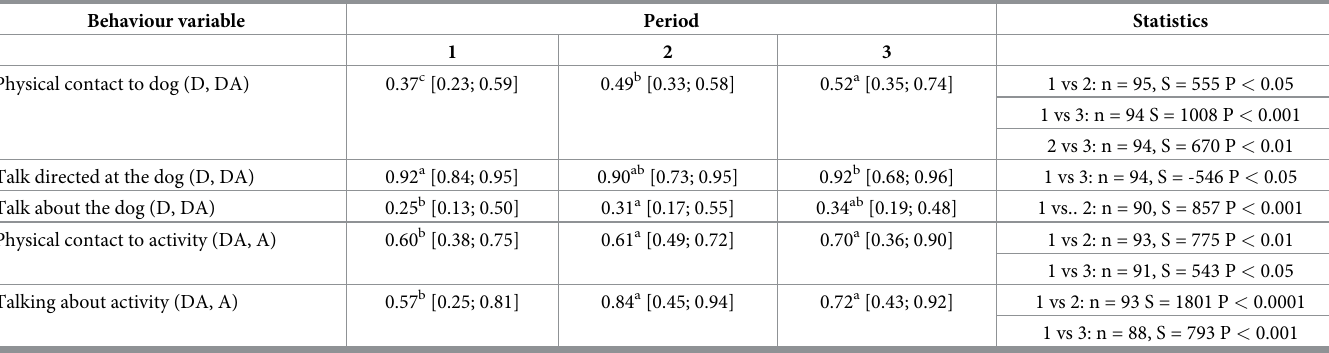
Table 6. The estimated probabilities of behaviour related to either the dog (D and DA visits) or the activity (DA and A visits). Behaviour variable Period